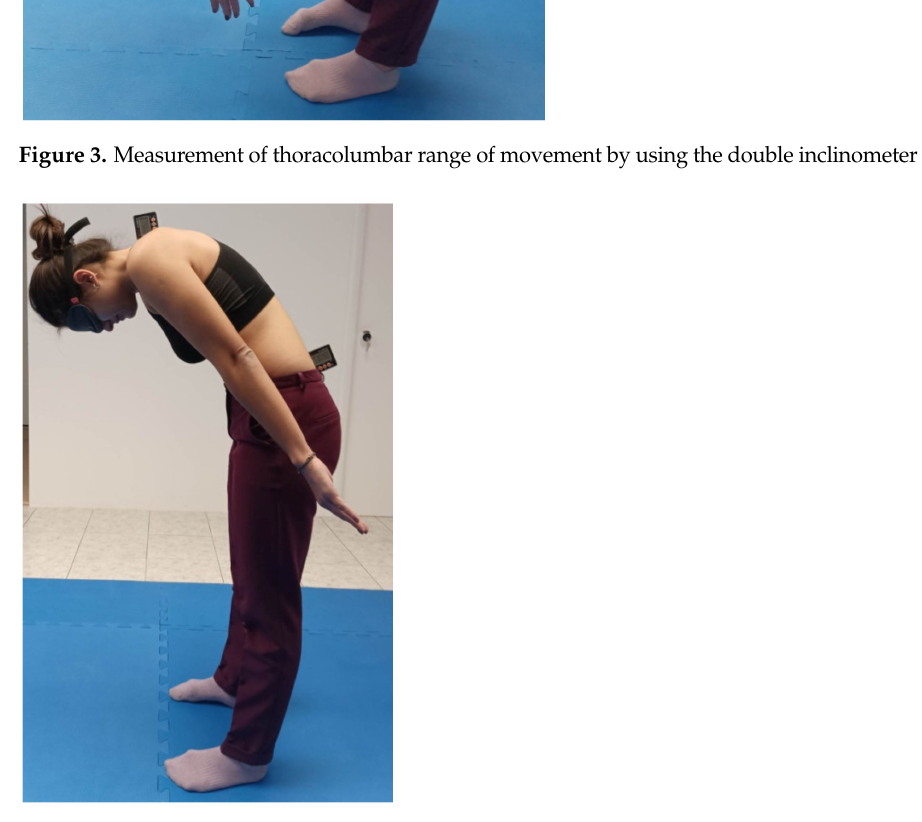
Figure 4. Measurement of thoracolumbar joint position sense by using the double inclinometer